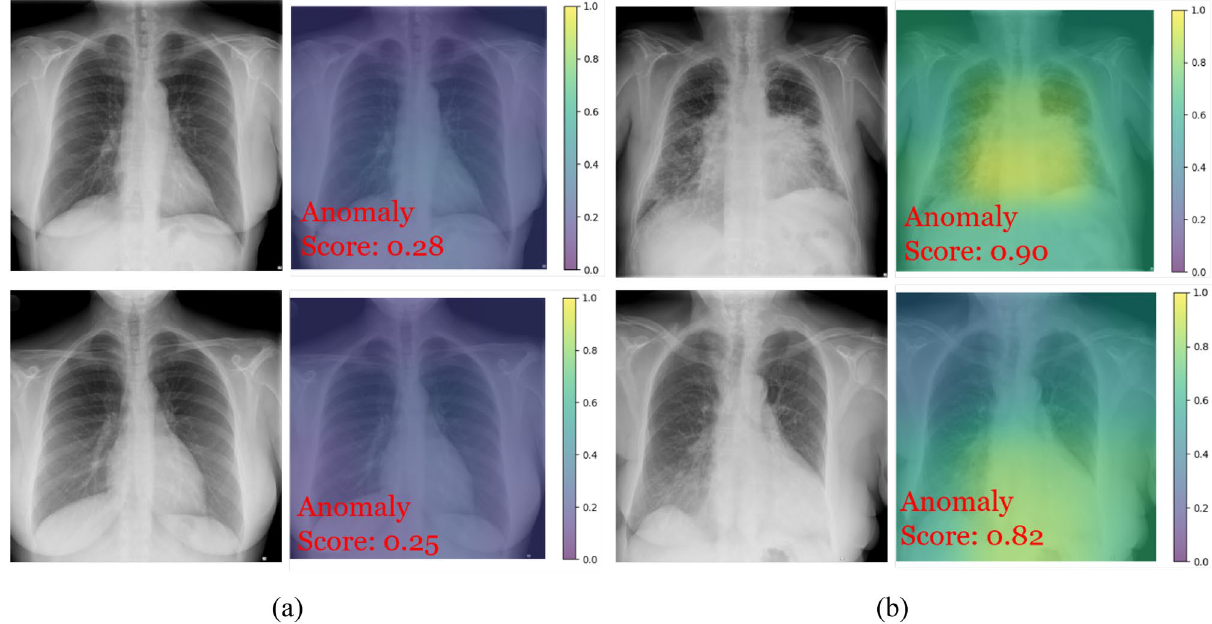
Figure 6. Radiographs of selected correctly classified examples—the anomaly scores were generated by the proposed method that showed the best performance in the experiments: ( a ) Truth label: normal, predicted label: normal; ( b ) truth label: abnormal, predicted label: